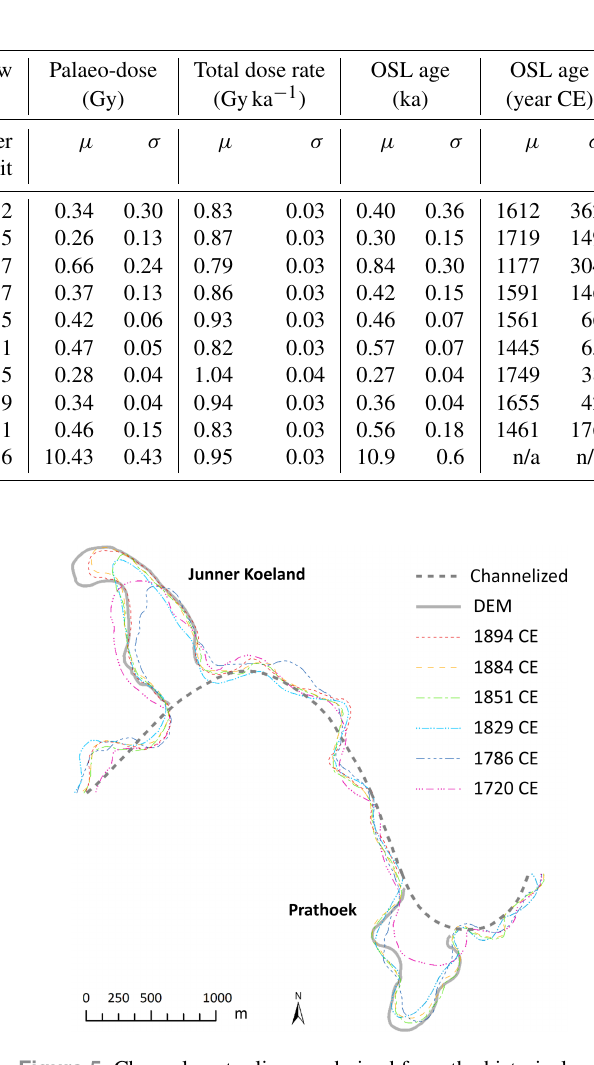
fit the data well. The graphical output of the model as gen- erated by OxCal is displayed on the right in Fig. 7b and d and demonstrates the improvement of the geochronology af- ter the Bayesian modelling compared to the un-modelled data points shown on the left in Fig. 7a and